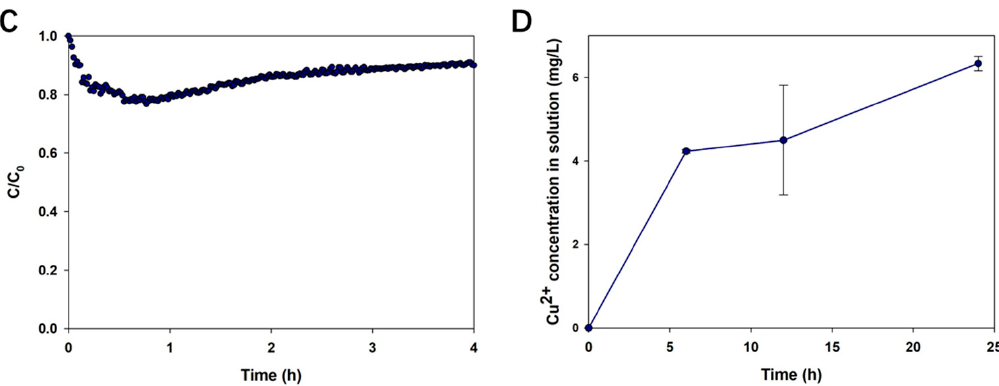
Figure 7. Size distribution ( A ); interaction energy ( B ); dynamic sedimentation ( C ); and dynamic dissolution ( D ) of CuO NPs in the LMWOA mixture.